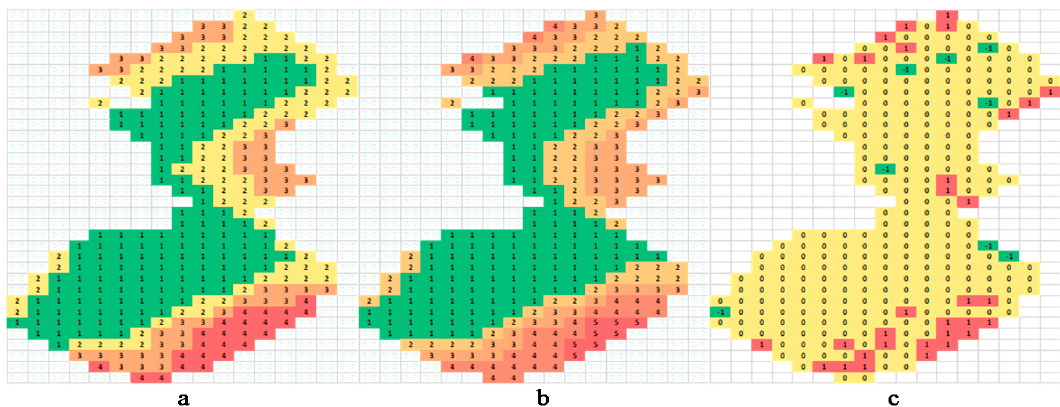
Figure 12. Thermal states of the landfill in ( a ) February 2010 and ( b ) September 2011, and ( c ) thermal status difference.